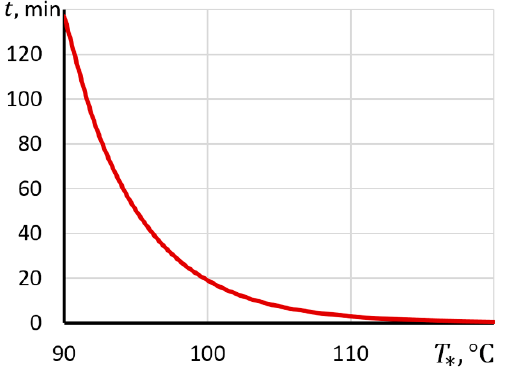
Figure 2. The thermal exposure time for death of 99% of bacterial spores at different temperatures.